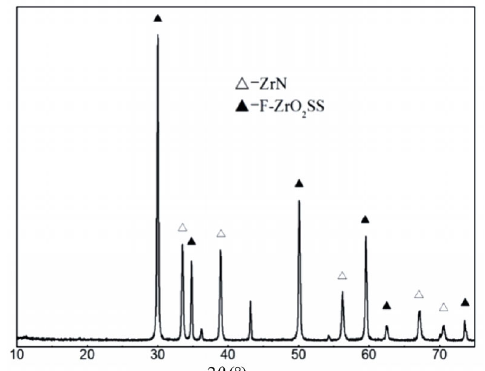
Fig. 4 XRD pattern of the sample with ZrN:ZrO 2 :Y 2 O 3 = 4:5.4:0.6.